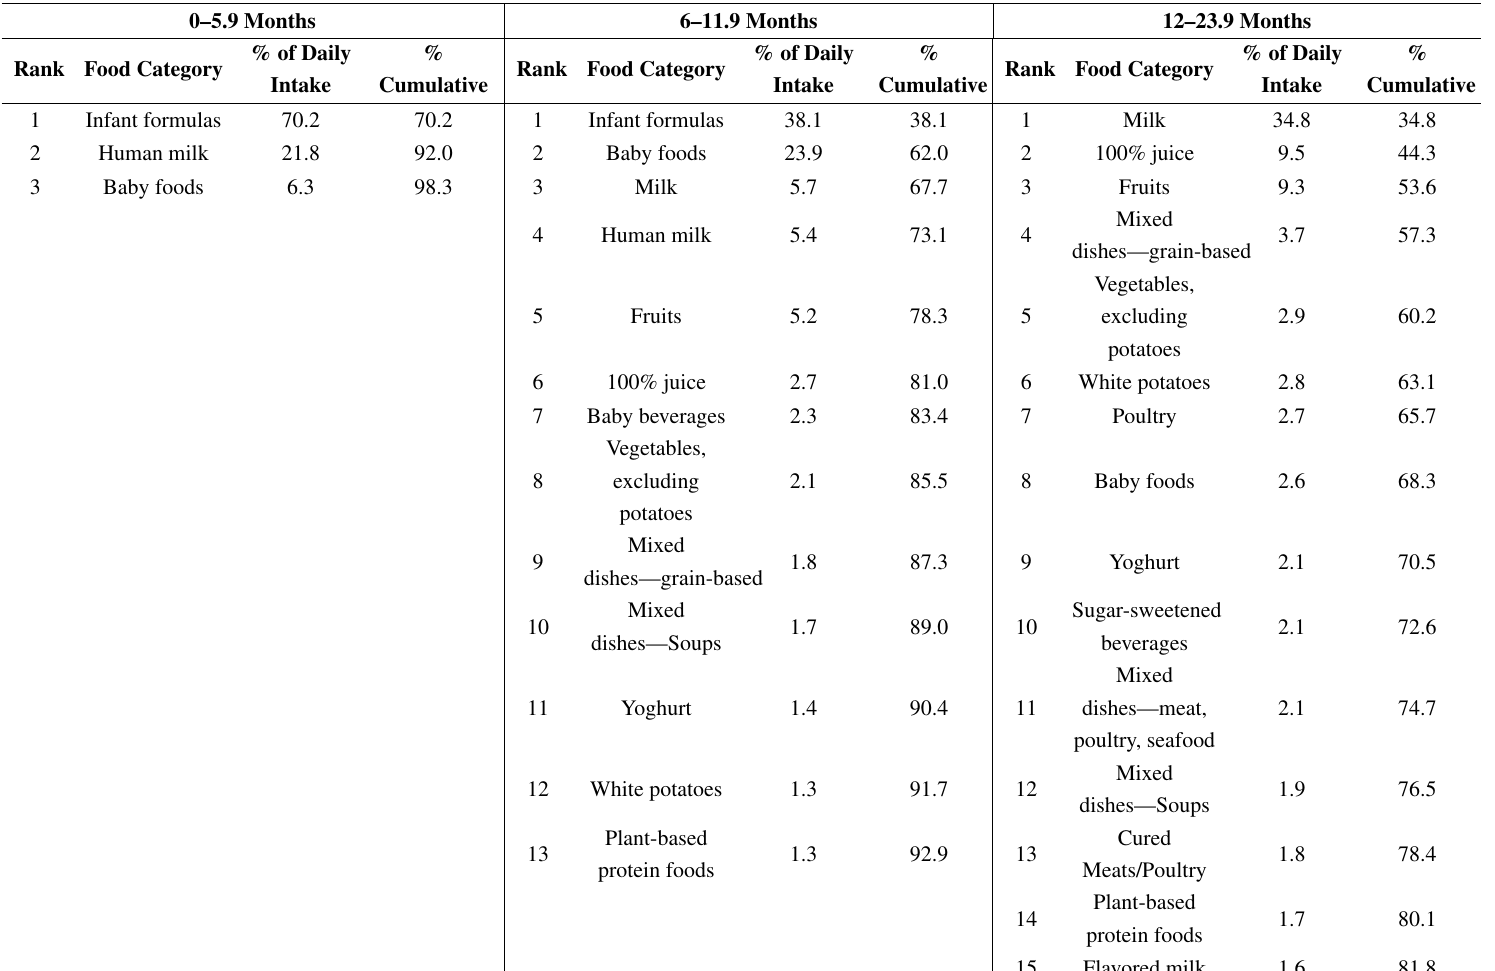
Food sources of potassium among US infants and toddlers aged 0–23.9 months by age group: NHANES 2005–2012 ( n = 2740) a